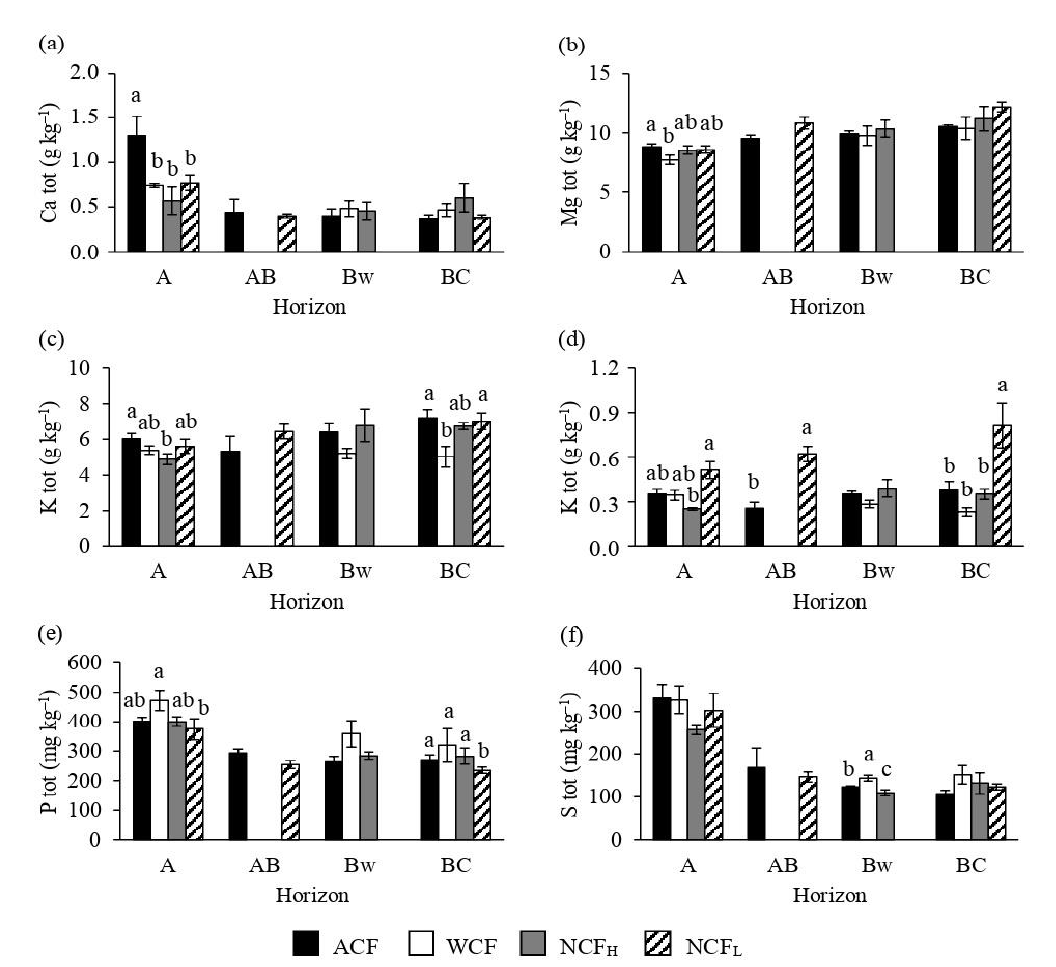
Figure 4. Concentrations of total calcium (Ca tot; a ), magnesium (Mg tot; b ), potassium (K tot; c ), sodium (Na tot; d ), phosphorus (P tot; e ) and sulfur (S tot; f ) of soils under an abandoned chestnut forest (ACF), a chestnut forest for wood production with a tree density of 151 plants ha − 1 (WCF), a chestnut forest for nut production with a tree density of 120 plants ha − 1 (NCF H ) and a chestnut forest for nut production with a tree density of 98 plants ha − 1 (NCF L ). Error bars are the standard errors. Within each horizon, different letters indicate significant differences by Tukey’s t -test p ≤ 0.05.